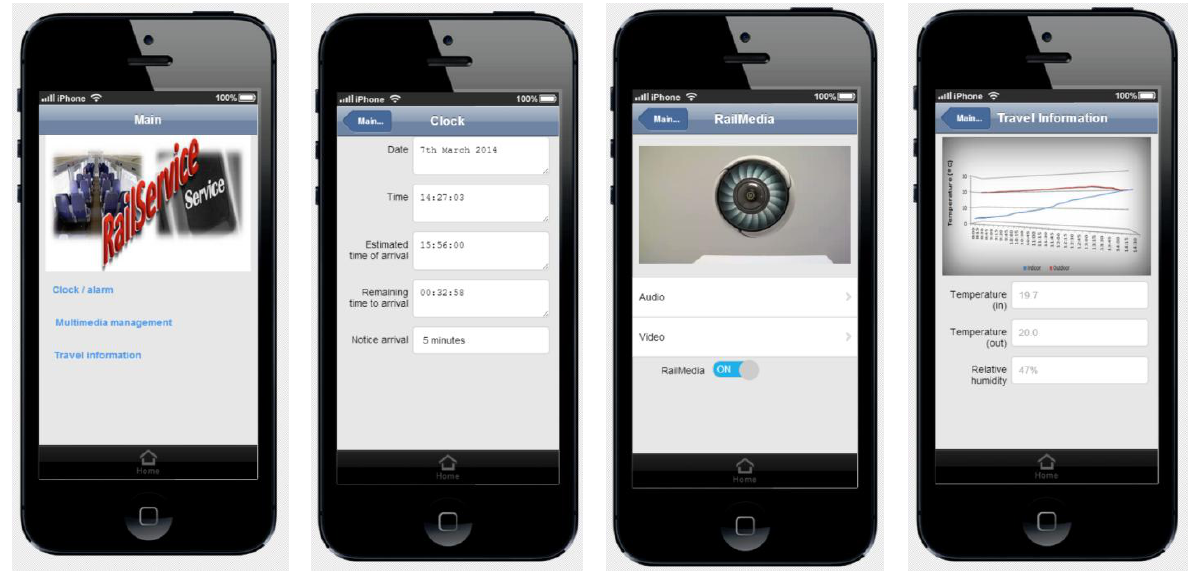
Figure 15. RailService’s screen captures.